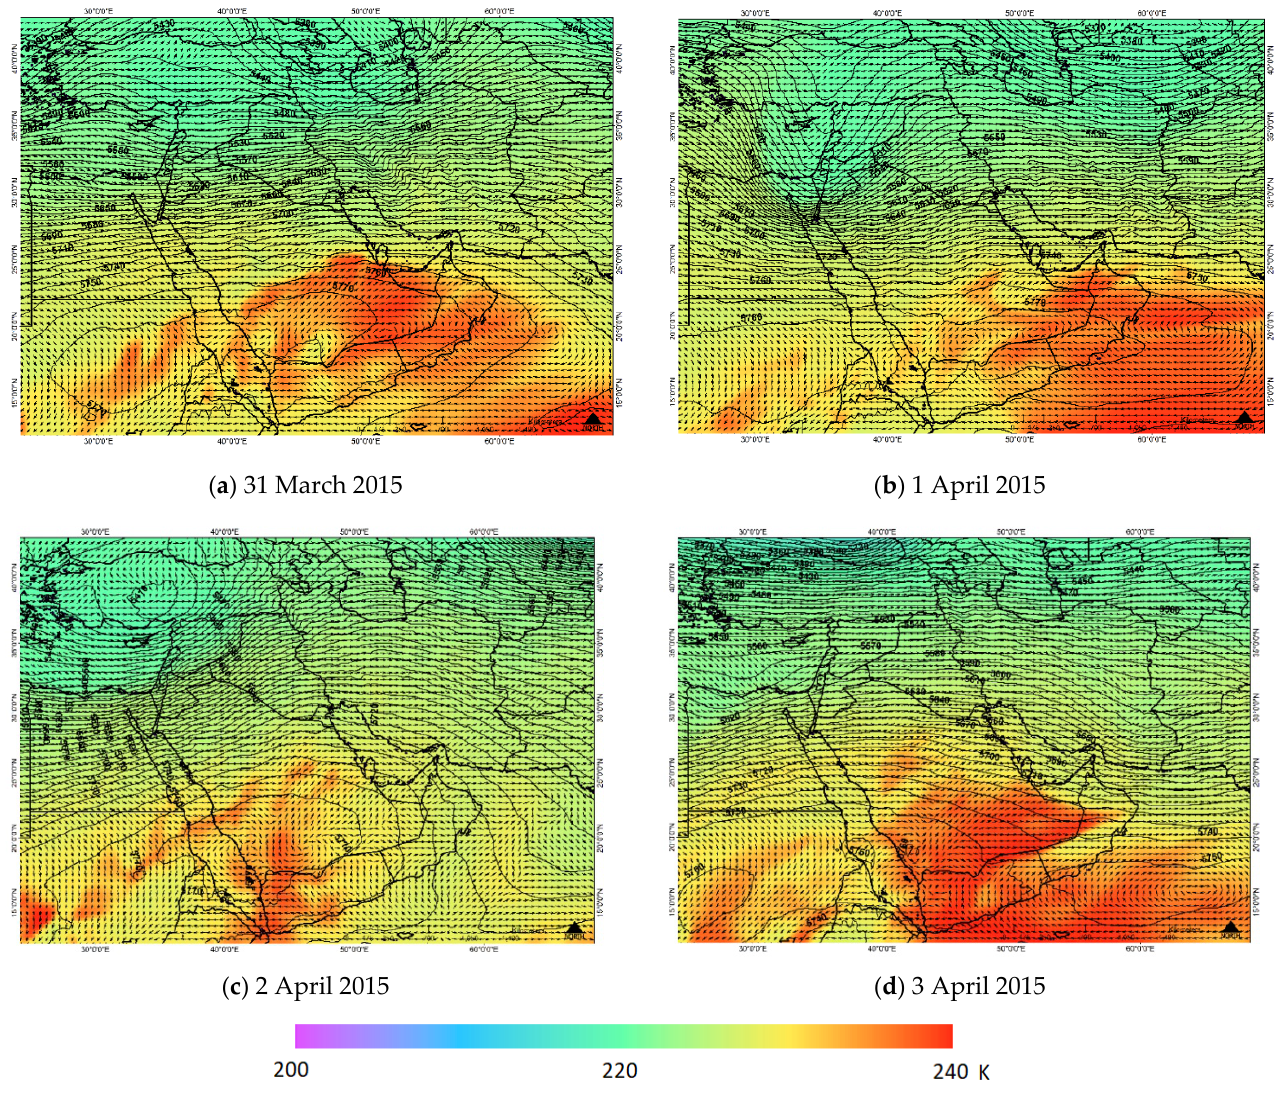
Figure 3. Contours indicating daily geopotential heights (m) in the mid-troposphere (500 hPa) overlaid with 500 hPa wind vectors (m/s) and temperature (K) derived from ERA5 data for the period 31 March to 3 April 2015 (12:00 UTC) ( a – d ).